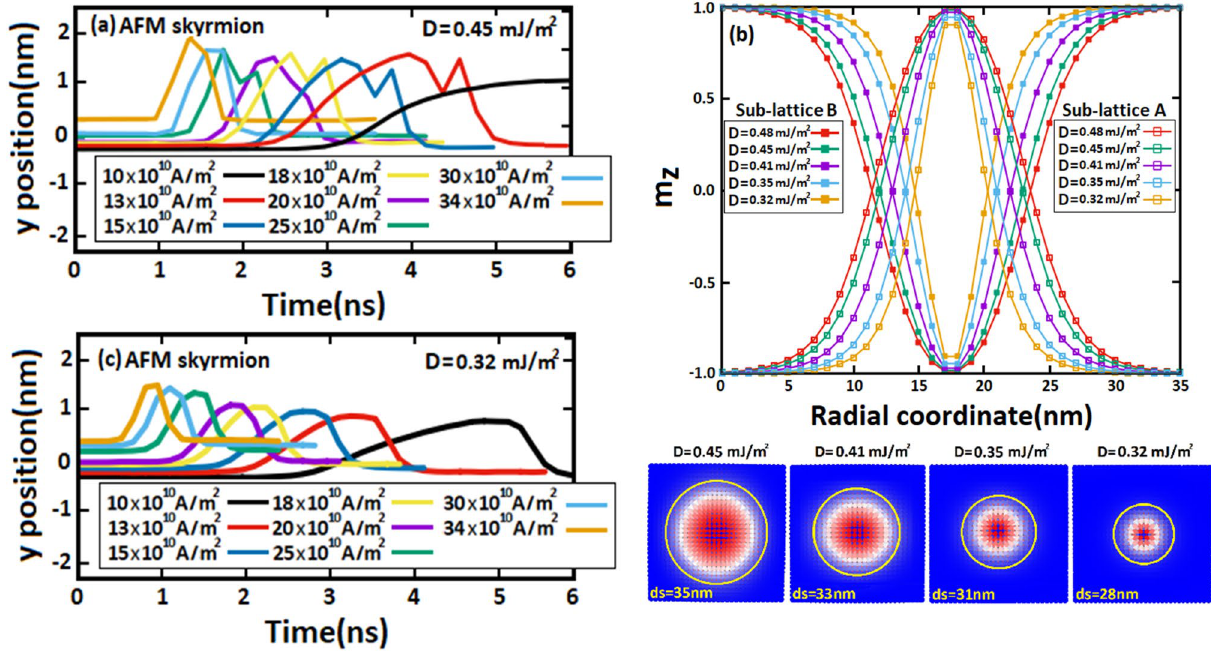
Figure 7. Temporal evolution of ( a,c ) AFM skyrmion position along the y-axis for different DMi strengths in a racetrack memory. ( b ) Out-of-plane magnetization along the z-axis in the sub-lattice (A) and sub-lattice (B) as a function of the radial